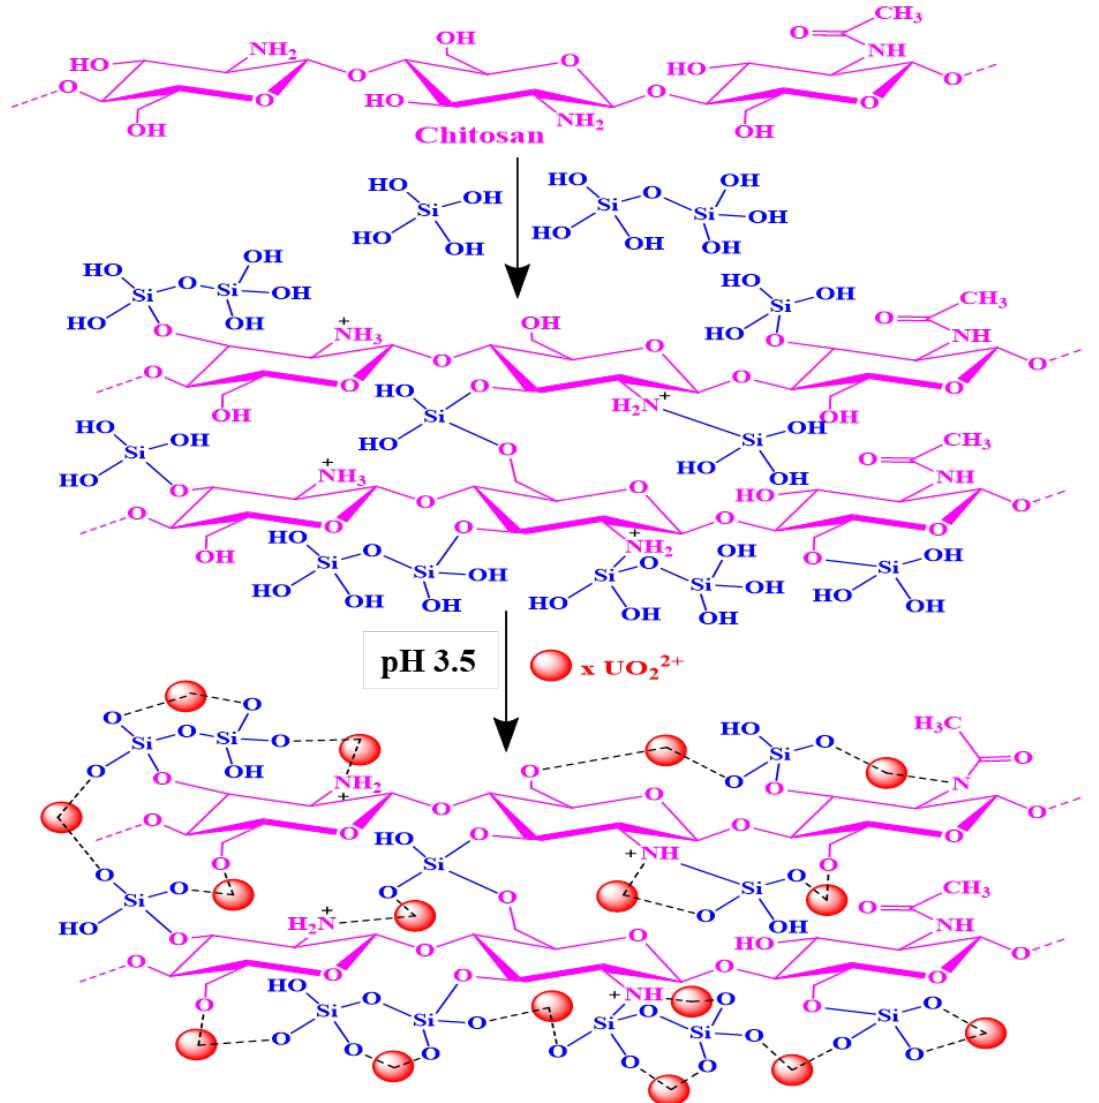
Figure 8. The graphical chart for the adsorption SiO 2 /CS and U(VI) ions.